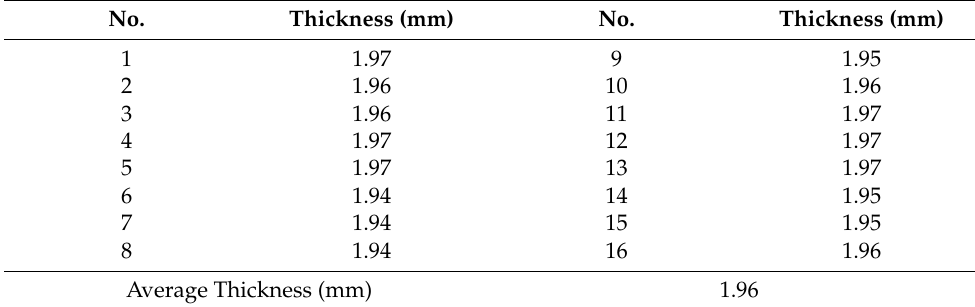
Table 1. Thickness measurement data.